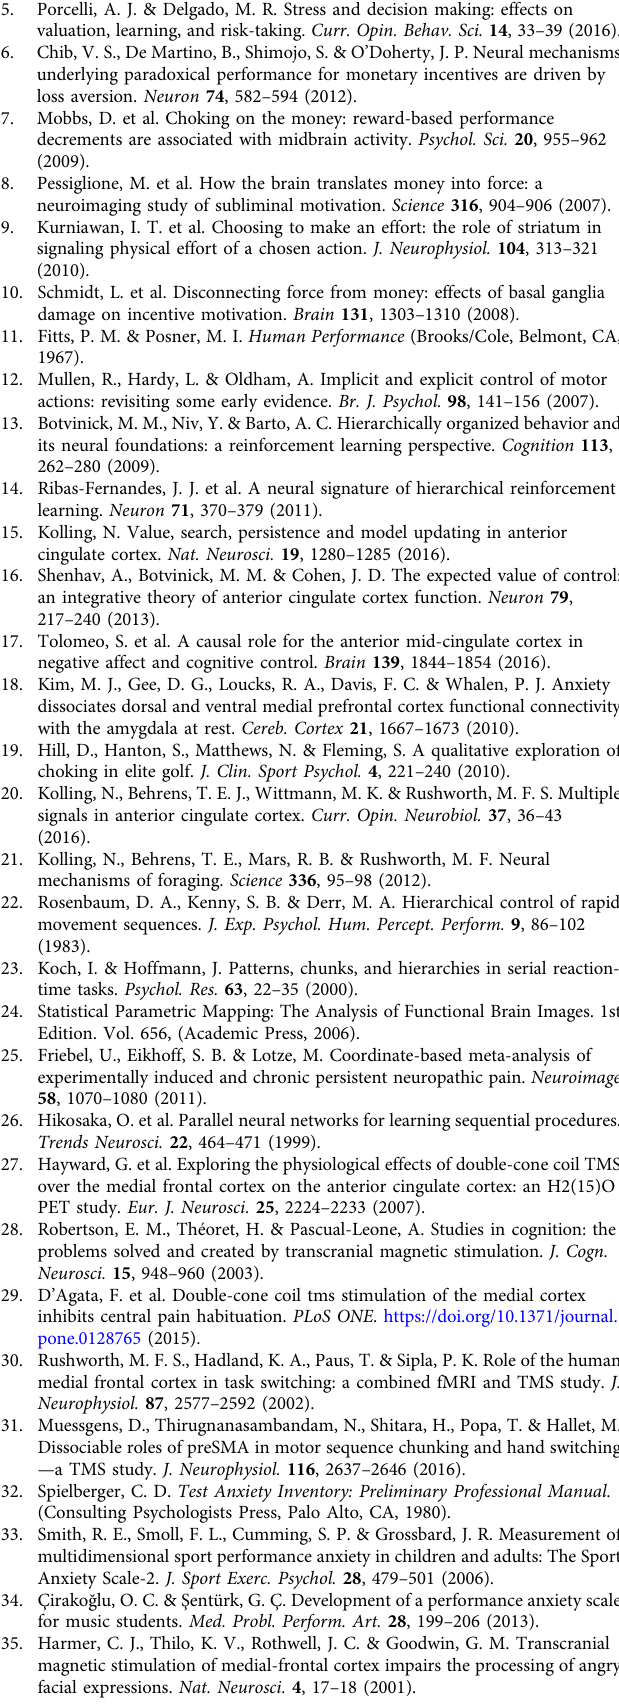
(Fig. 2d) between part learners and single learners. The coordinates were indi- vidually adjusted using the inverse normalization method embedded in SPM12 (normalization based on the inverse deformation fi eld). We also individually localized the toe area in the primary motor cortex as the MNI coordinates ( − 8, − 22, 64) following previous studies 36,37 . Brainsight (Rogue Research Inc.) was used to register the stimulus sites onto the individual T1 image. The Brainsight navigation procedure allowed for precise placement of the coil on the distal dACC and the reference toe area.